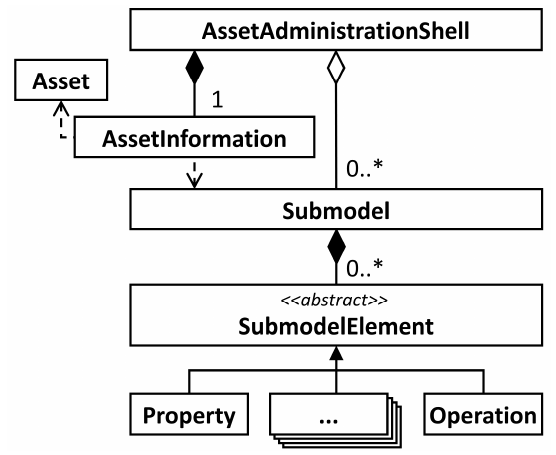
Figure 1. Simplified metamodel of the Asset Administration Shell (v3.0RC01) based on